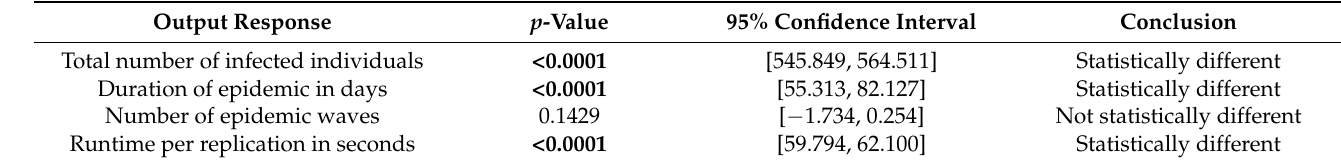
Table 8. Results of the paired t -test for the baseline model.